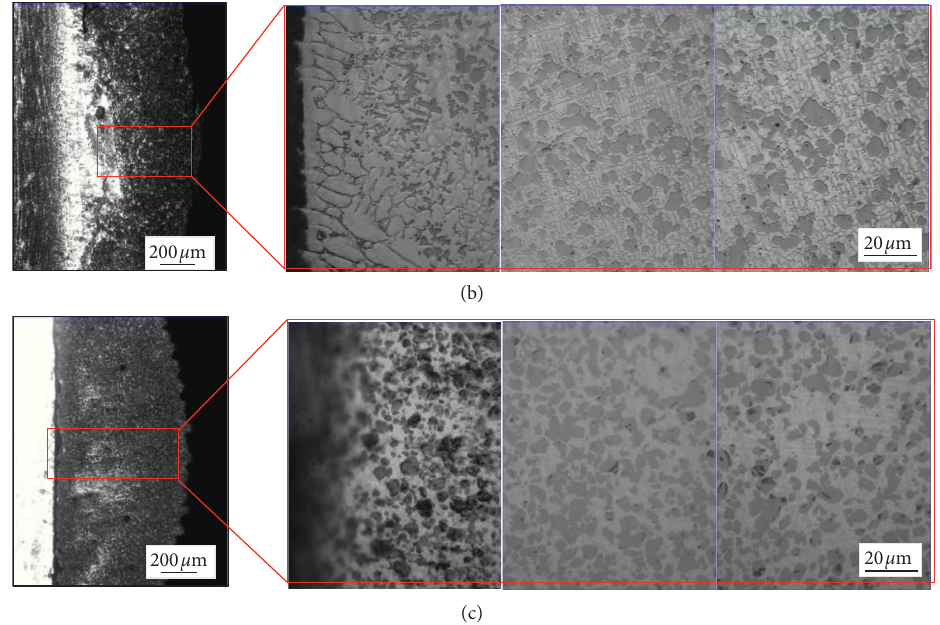
Figure 8: Microstructure of the Co50/TiC claddings: (a) B cladding, (b) C cladding, and (c) D cladding.